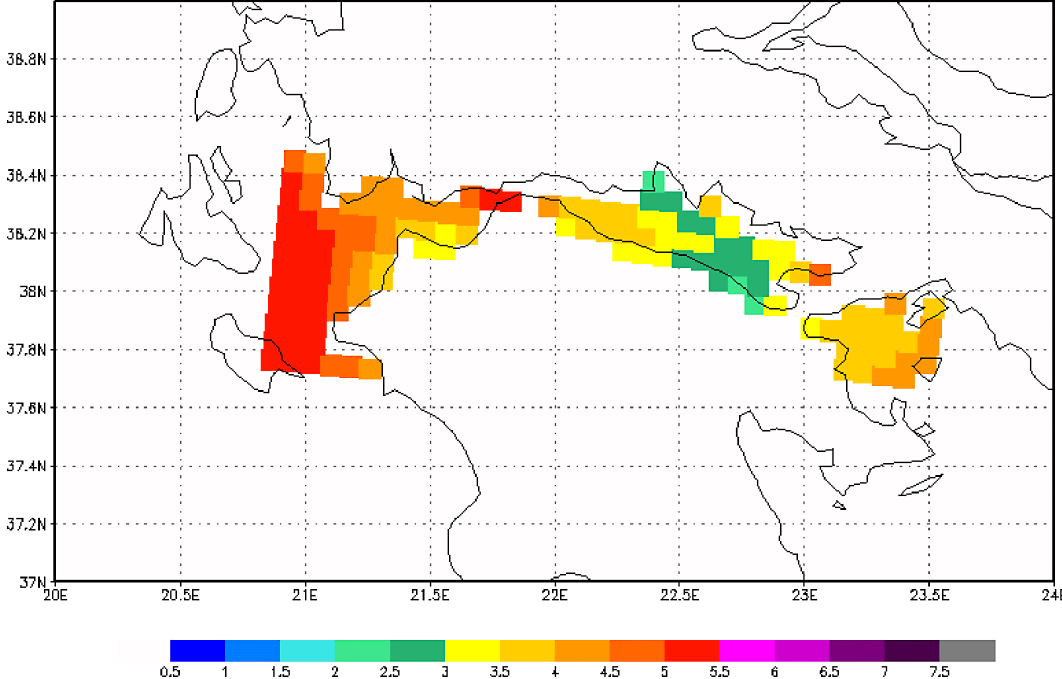
Fig. 3. Mean wind speed at 10m derived from 6h model data for the period January 2007–December 2011.